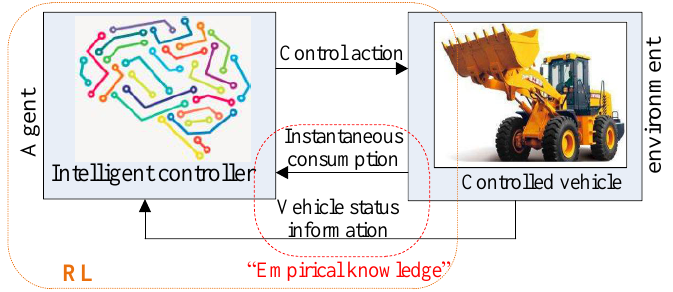
Figure 17. Energy optimization framework based on an intelligent EMS.